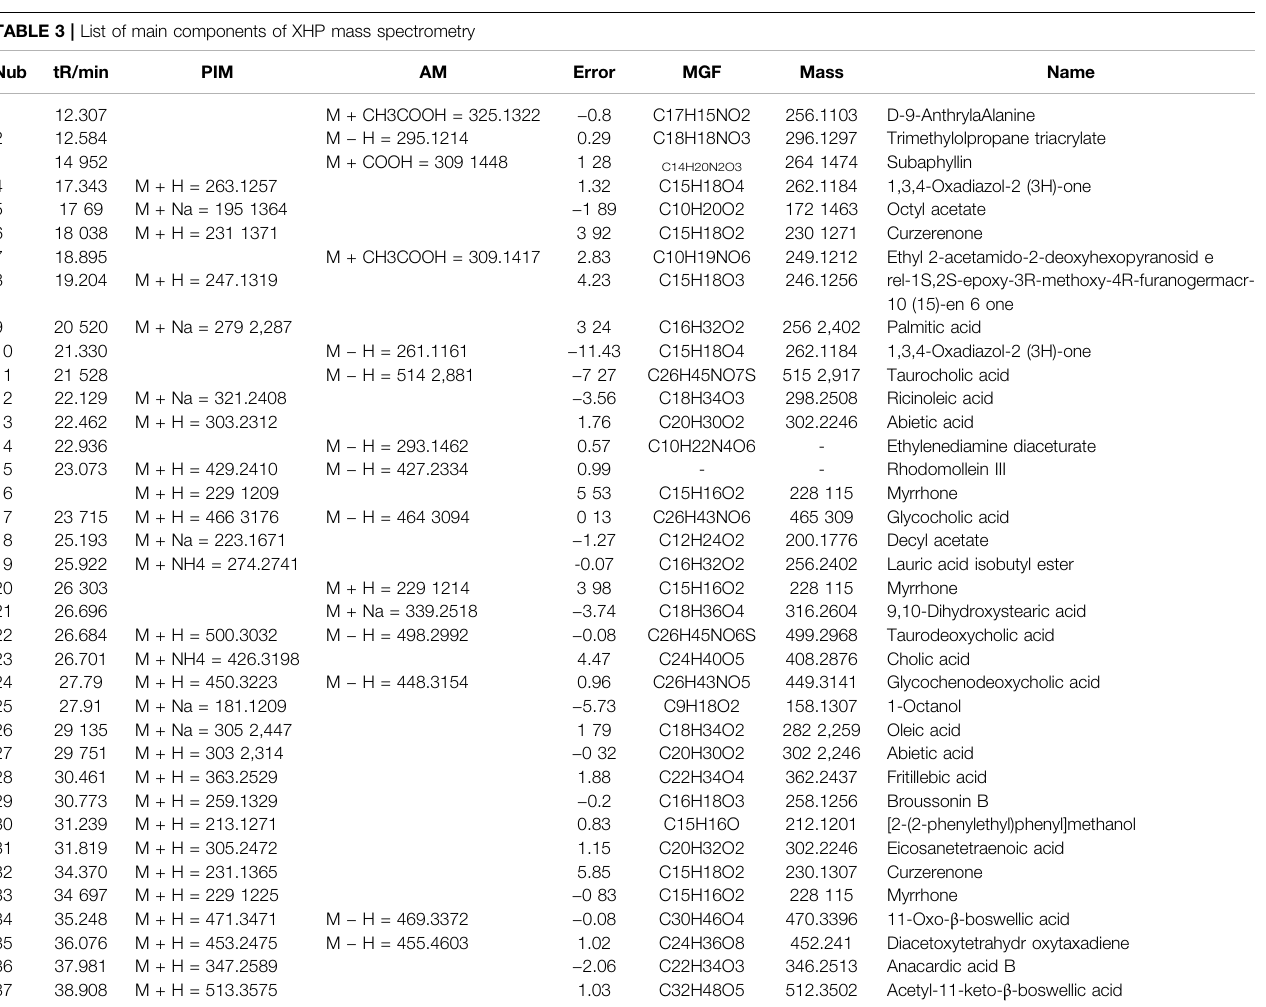
TABLE 3 | List of main components of XHP mass